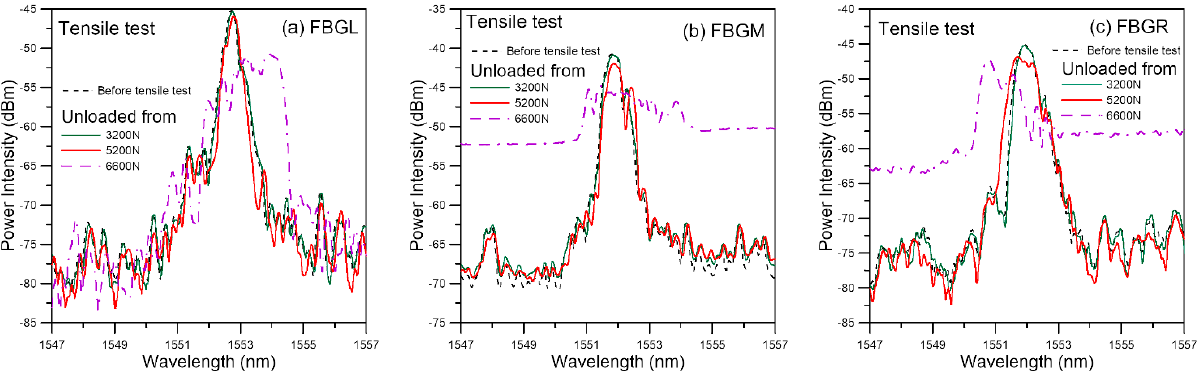
6 of 16 Figure 3. Evolution of FBG spectra measured at various loads as tensile loading increases. 3.1.2. Damage Monitoring Using Unload Spectra Two reference loads, namely 0 N and 400 N, were chosen. In each case, as measure-